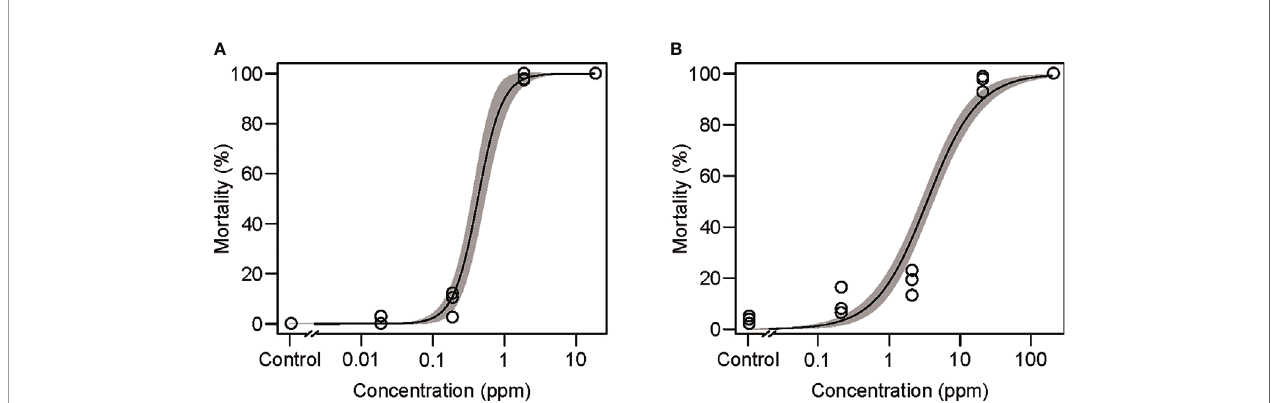
FIGURE 4 | Effects of the acaricides (A) abamectin and (B) bifenazate delivered via the mesh method in adult Tetranychus urticae females at 25°C for 24 and 48 h, respectively. Data were collected from three independent experimental runs and presented with a regression curve and a 95% con fi dence interval band. In each experimental run, 25 to 92 mites were used.